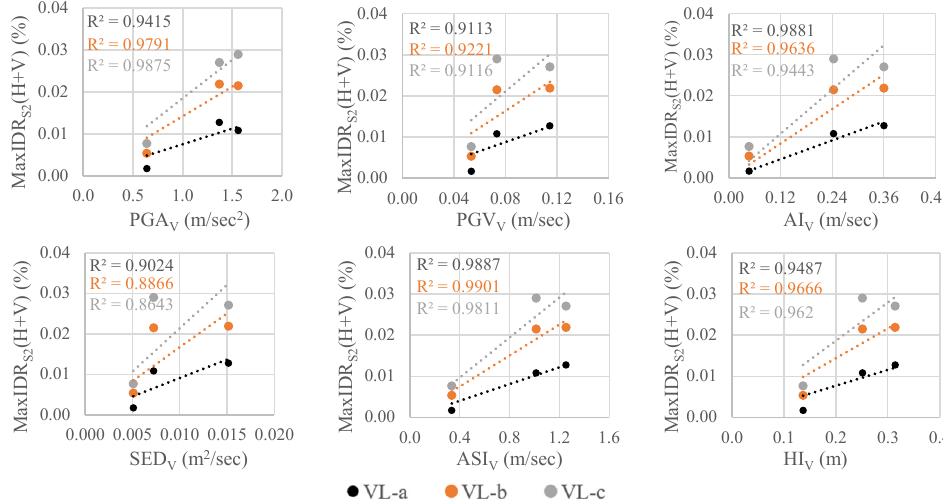
Figure 20. Correlations between the GMPs of the V components (GMP V ) and the maximum IDRs obtained for the second story of the case–study structure from the simultaneous application of the H and V components, maxIDR S2 (H + V). In each image, with the only exception of the PGA V plot, from left to right, earthquakes #3, #1, and #2; in the PGA V plot ( top left ), from left to right, earthquakes #3, #2, and #1.